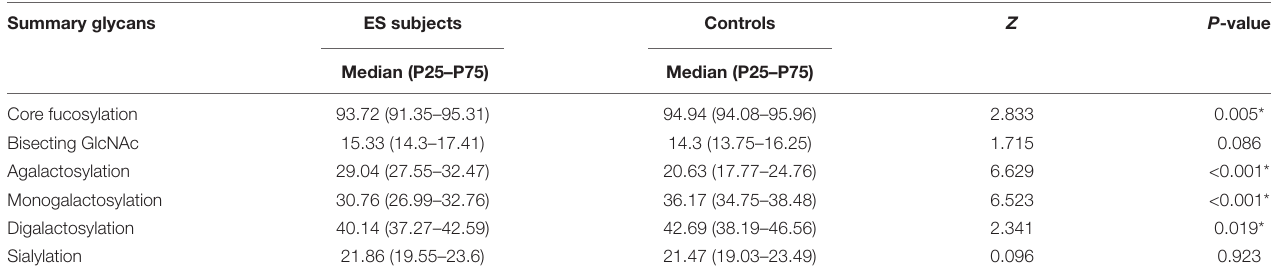
FIGURE 1 | Fucosylation on Ig G in Epilepsy patients and the healthy controls. GP, glycan peak; F, fucose; S, Sialic acid; B, bisecting N-acetylglucosamine (GlcNAc); G, galactose; ↑ , the glycan in Epilepsy group in significantly higher than that in the controls; and ↓ , the glycan in Epilepsy group in significantly lower than that in the controls. *Represents the extreme values in the sample data. TABLE 4 | Relative abundance (%) of main IgG glycome features in ES patients and the healthy